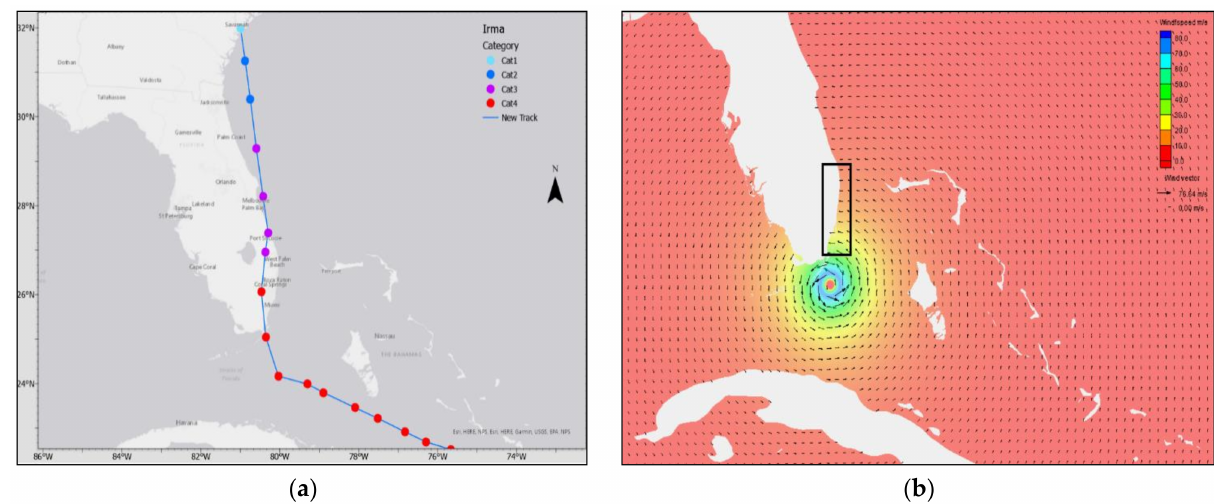
Figure 4. ( a ) Hurricane Irma-hypothetical track hitting Miami; ( b ) Wind field used in the coupled model—a snapshot close to landfall. Location of the nested domain shown in